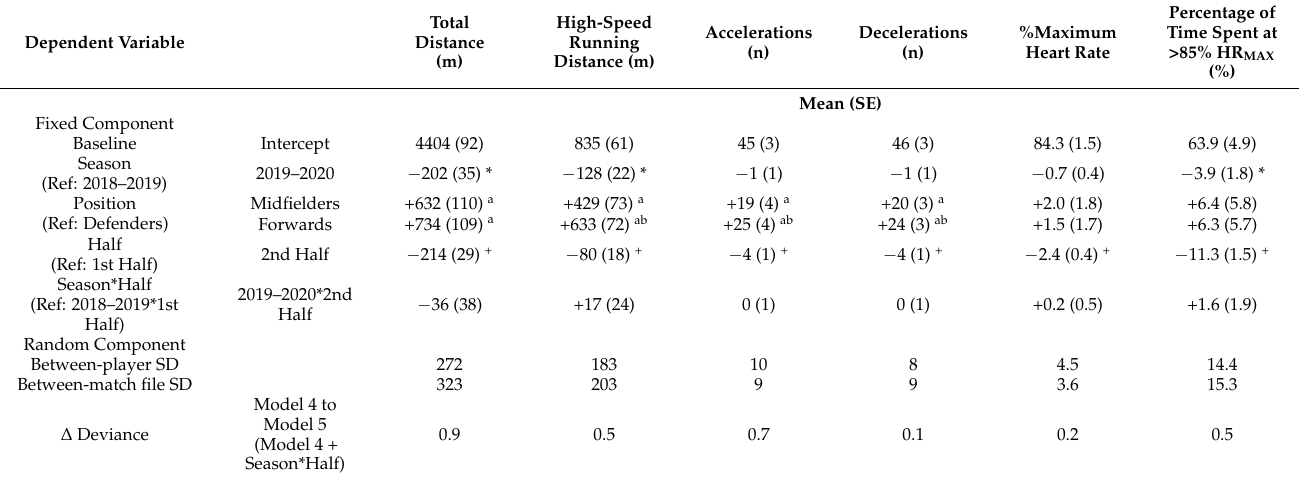
Table 4. Multilevel models examining the effects of season, position and half, and a cross-level interaction between season and half on normalised Global Positioning System (GPS) and heart rate variables (model 5), using 1st and 2nd half data, from matches where the playing format was 2 × 35 min halves (2018–2019 season) or 2 × 2 × 17.5 min